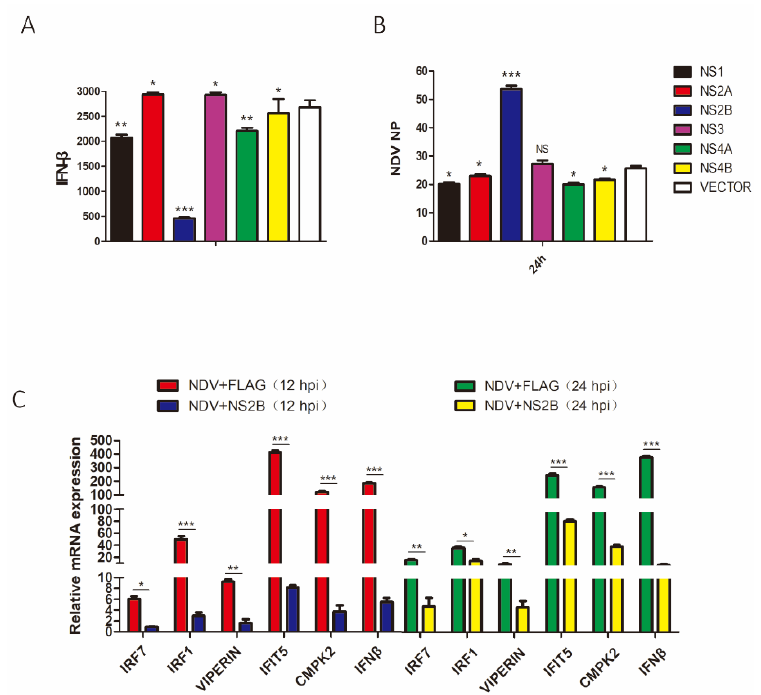
Figure 6. The effects of DTMUV NS2B-overexpression on NDV replication and the induction of IFN- β , as well as IFN-reducible genes. ( A ) DF1 cells were transfected with plasmids expressing Myc-tagged DTMUV NS1, NS2A, NS2B, NS3, NS4A, or NS4B, respectively, and infected with NDV at an MOI of 1. Cells were harvested at 24 h post-infection of NDV, and the protein expression levels of NS1, NS2A, NS2B, NS3, NS4A, and NS4B in poly(I:C)-treated cells were determined by Western blot with anti-Myc serum. ( B ) IFN- β induction at the mRNA level from above samples was determined by RT-qPCR and presented. Error bar represents the standard error of three replicate experiments. T tests were performed by comparing the vector-transfected sample (white) to samples transfected with each of the viral gene. ( C ) NDV copy numbers in above samples were determined and presented. Error bar represents the standard error of three replicate experiments. T tests were performed by the vector transfected sample (white) to each of the viral gene transfected samples. ( D ) DF1 cells were transfected with a plasmid expressing Flag-tagged DTMUV NS2B and infected with NDV at an MOI of 1. Cells were harvested at 12 and 24 hpi, and the expression of IRF7, IRF1 VIPERIN, IFIT5, CMPK2, and IFN- β at the mRNA level was determined by RT-qPCR and presented. Error bar represents the standard error of three replicate experiments. T tests were performed between samples transfected with Flag-NS2B and empty vector. (ns, nonsignificant; * p < 0.05; ** p < 0.01; *** p < 0.001 ）